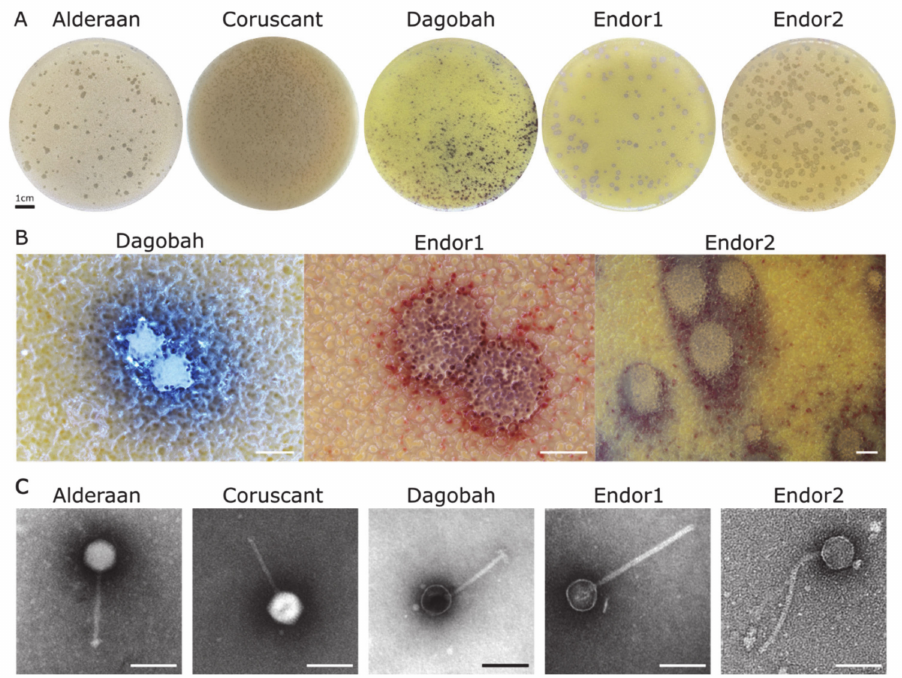
Figure 1. Morphology observation of five novel Streptomyces phages. ( A ) Plaque morphologies of the five phages. Double agar overlays were performed to infect S.venezuelae ATCC 10712 with the phages Alderaan and Coruscant, and S. coelicolor M600 with the phages Dagobah, Endor1, and Endor2. Plates were incubated overnight at 30 ◦ C and another day (3 days in the case of Dagobah) at room temperature to reach full maturity of the bacterial lawn. ( B ) Close-ups of phage plaques imaged using a stereomicroscope Nikon SMZ18. S. coelicolor M145 was infected by phages using GYM double agar overlays. The plates were incubated at 30 ◦ C overnight and then kept at room temperature for two (Endor1 and Endor2) or three days (Dagobah). Scale bar: 1 mm. ( C ) Transmission electron microscopy (TEM) of phage isolates. The phage virions were stained with uranyl acetate. Scale bar: 150